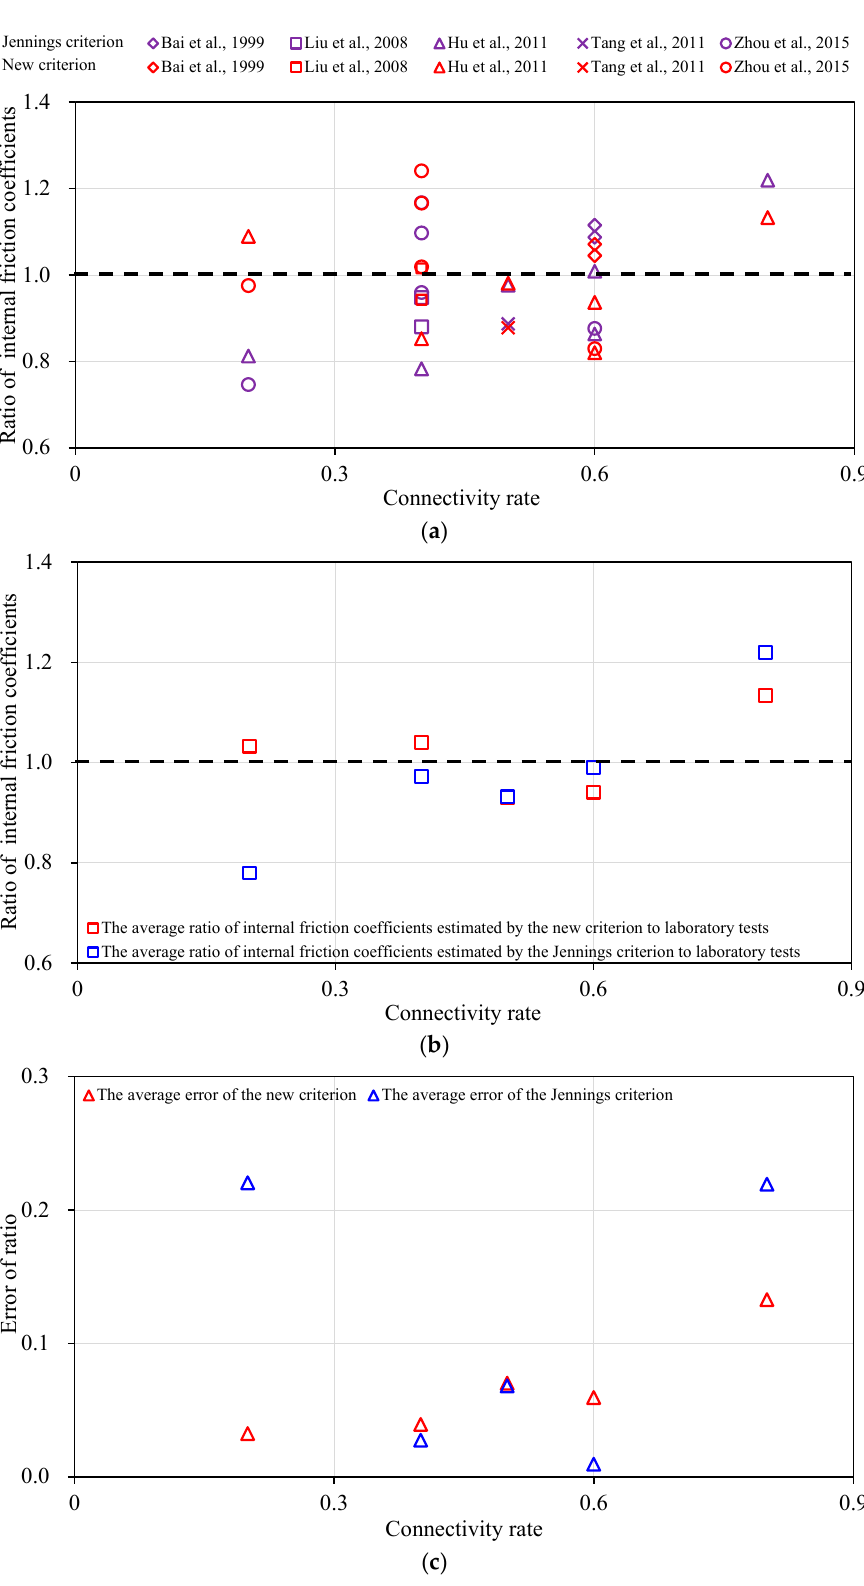
Figure 4. Comparison of the ratios of the estimated internal friction coefficients by the Jennings and new criterions to the test results of the internal friction coefficients with various connectivity rates. ( a ) The ratio of the internal friction coefficient with the connectivity rate; ( b ) The average ratio of the internal friction coefficient with the connectivity rate; ( c ) The error with the connectivity rate.